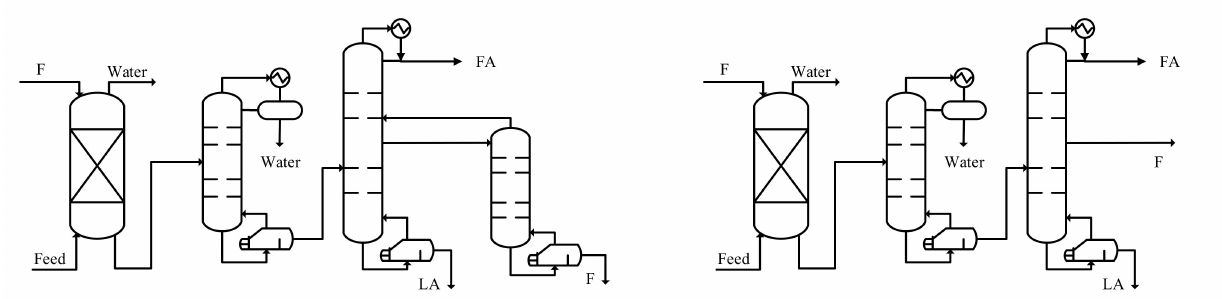
Figure 3. Intensified configurations. ( Left ): liquid-liquid-thermally equivalent configuration (LL-TE). ( Right ): liquid-liquid side stream column configuration (LL-SSC).